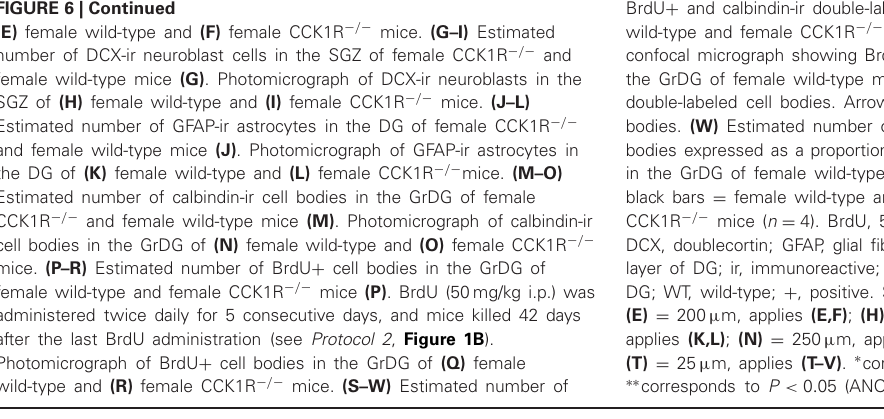
FIGURE 6 | Continued (E) female wild-type and (F) female CCK1R − / − mice. (G–I) Estimated number of DCX-ir neuroblast cells in the SGZ of female CCK1R − / − and female wild-type mice (G) . Photomicrograph of DCX-ir neuroblasts in the SGZ of (H) female wild-type and (I) female CCK1R − / − mice. (J–L) Estimated number of GFAP-ir astrocytes in the DG of female CCK1R − / − and female wild-type mice (J) . Photomicrograph of GFAP-ir astrocytes in the DG of (K) female wild-type and (L) female CCK1R − / − mice. (M–O) Estimated number of calbindin-ir cell bodies in the GrDG of female CCK1R − / − and female wild-type mice (M) . Photomicrograph of calbindin-ir cell bodies in the GrDG of (N) female wild-type and (O) female CCK1R − / − mice. (P–R) Estimated number of BrdU + cell bodies in the GrDG of female wild-type and female CCK1R − / − mice (P) . BrdU (50mg/kg i.p.) was administered twice daily for 5 consecutive days, and mice killed 42 days after the last BrdU administration (see Protocol 2 , Figure 1B ). Photomicrograph of BrdU + cell bodies in the GrDG of (Q) female wild-type and (R) female CCK1R − / − mice. (S–W) Estimated number of